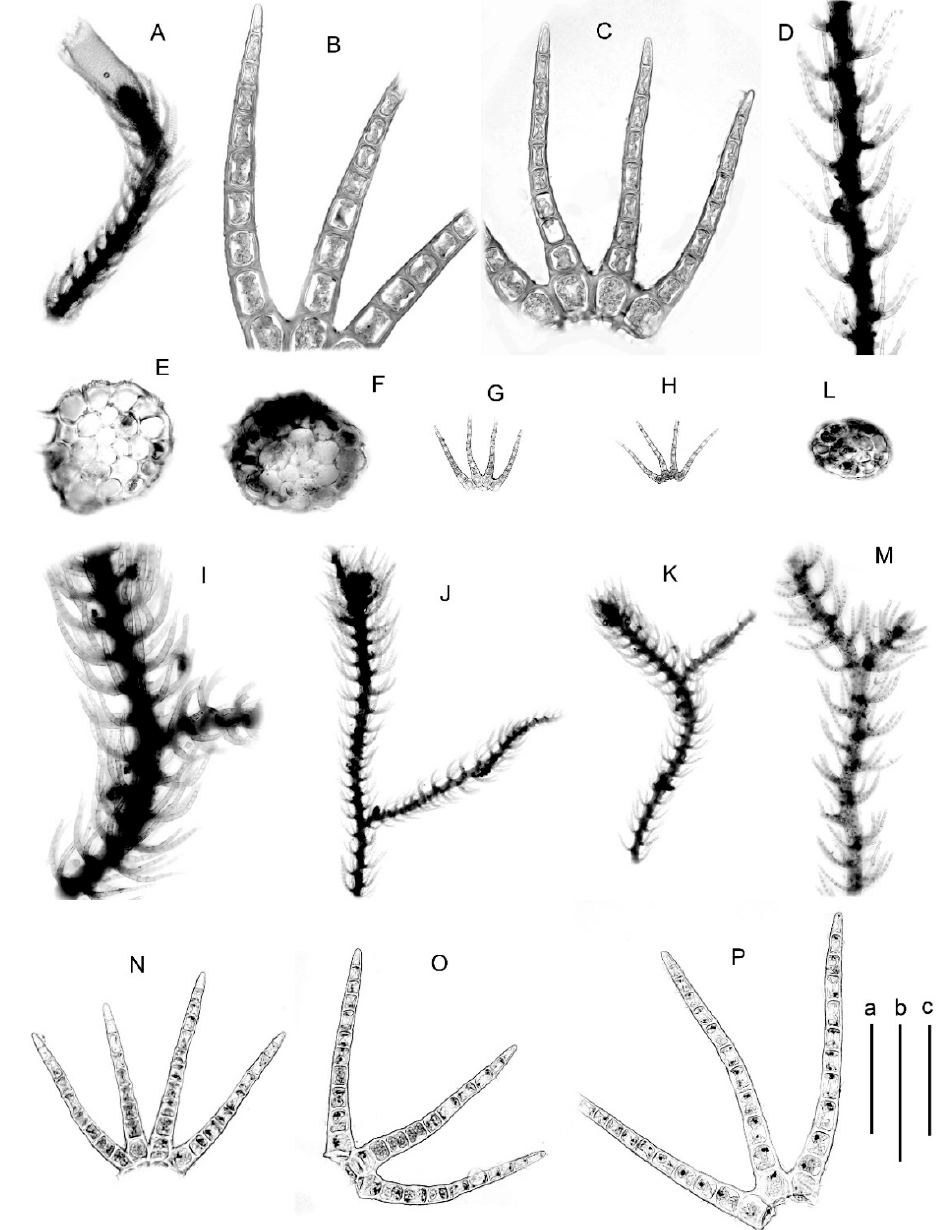
Figure 4. ( A ) Blepharostoma brevirete , from Mag-10-1-10 (VBGI); ( B – K ) B. epilithica , from J-11-13-15 ( L – P ) B. minor , from J-91-51-15 (VBGI). ( A , D , I – M )—plant habit; ( B , C )—leaf segments; ( E , F , L (VBGI); ( L) –( P ) B. minor , from J-91-51-15 (VBGI). ( A) ,( D) ,( I) –( M )—plant habit; ( B) ,( C )—leaf segments; ( E) ,( F) ,( L )—stem cross-section; ( G) ,( H) ,( N) –( P )—leaves. Scales: a—1 mm, for ( A) ,( J) ,( K ); b—500 µm,